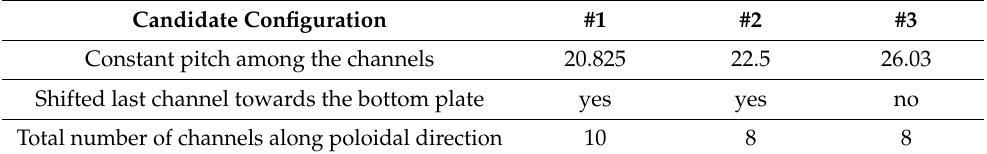
Table 5. Geometrical parameters for bottom cap refrigeration test cases.